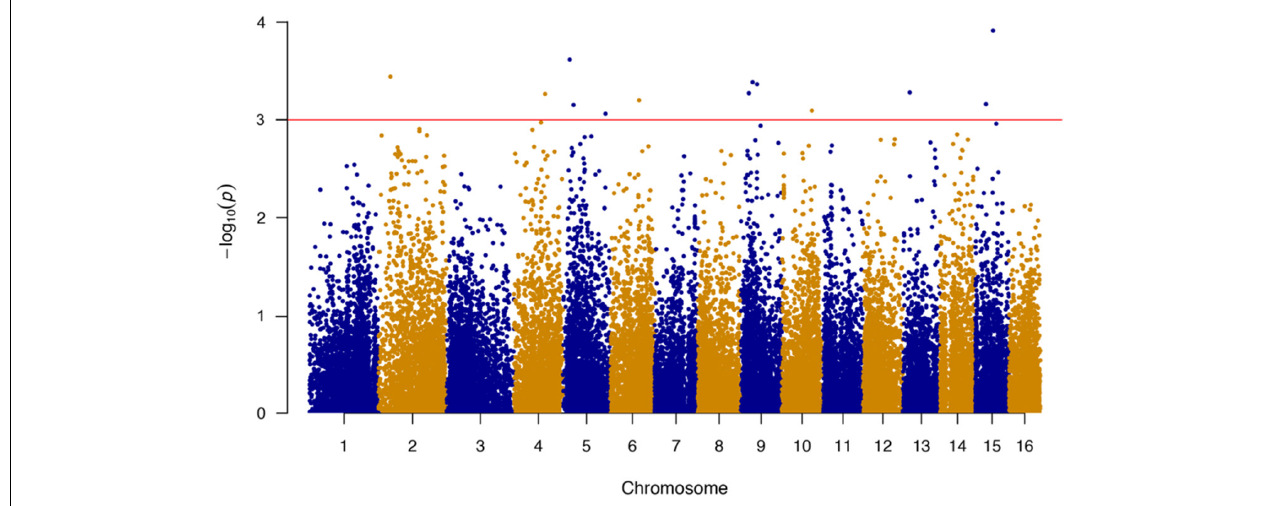
FIGURE 1 | Genome-wide association study (GWAS) of thermal tolerance traits with 38,079 SNPs in bay scallop. The red line indicates the genome-wide threshold as P -value of 0.001.